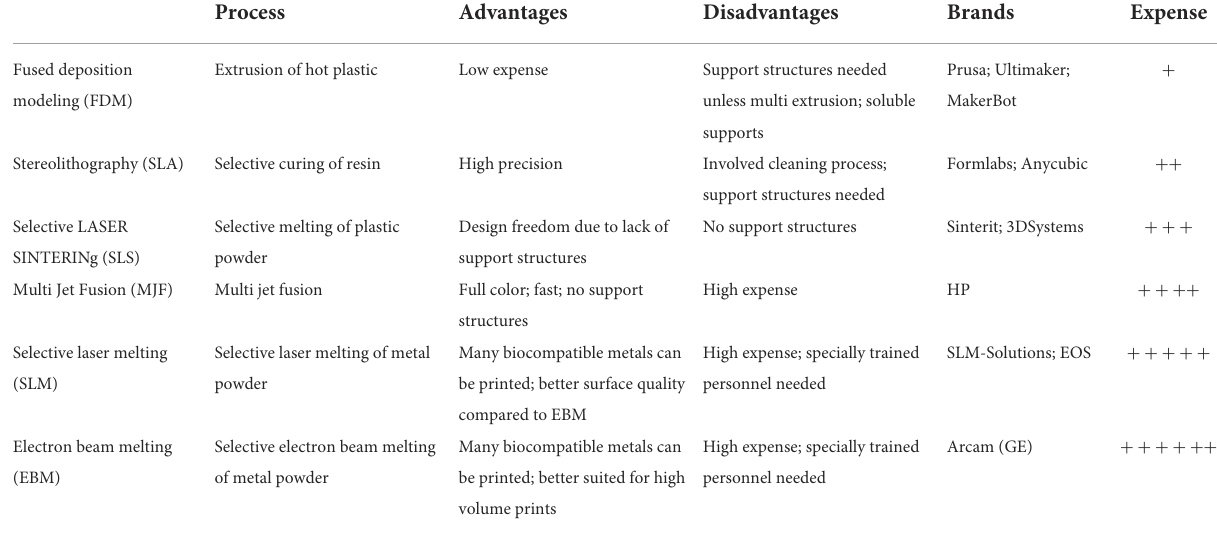
TABLE 3 3D-printing methods